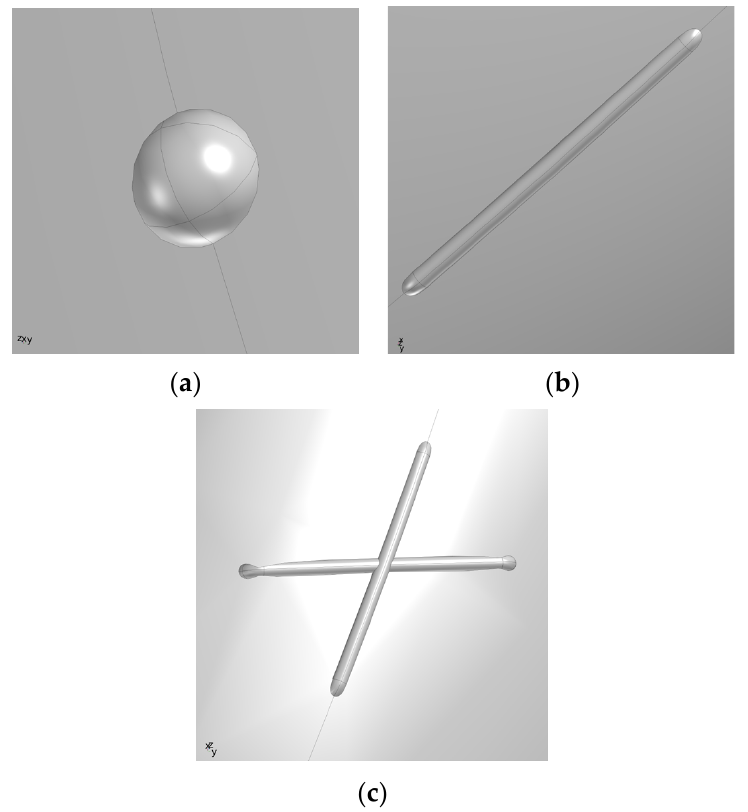
Figure 5. Defect location and partial local enlarged map of the elbow. ( a ) Schematic diagram of point defect; ( b ) Schematic diagram of trench defect; ( c ) Schematic diagram of double trench defect.